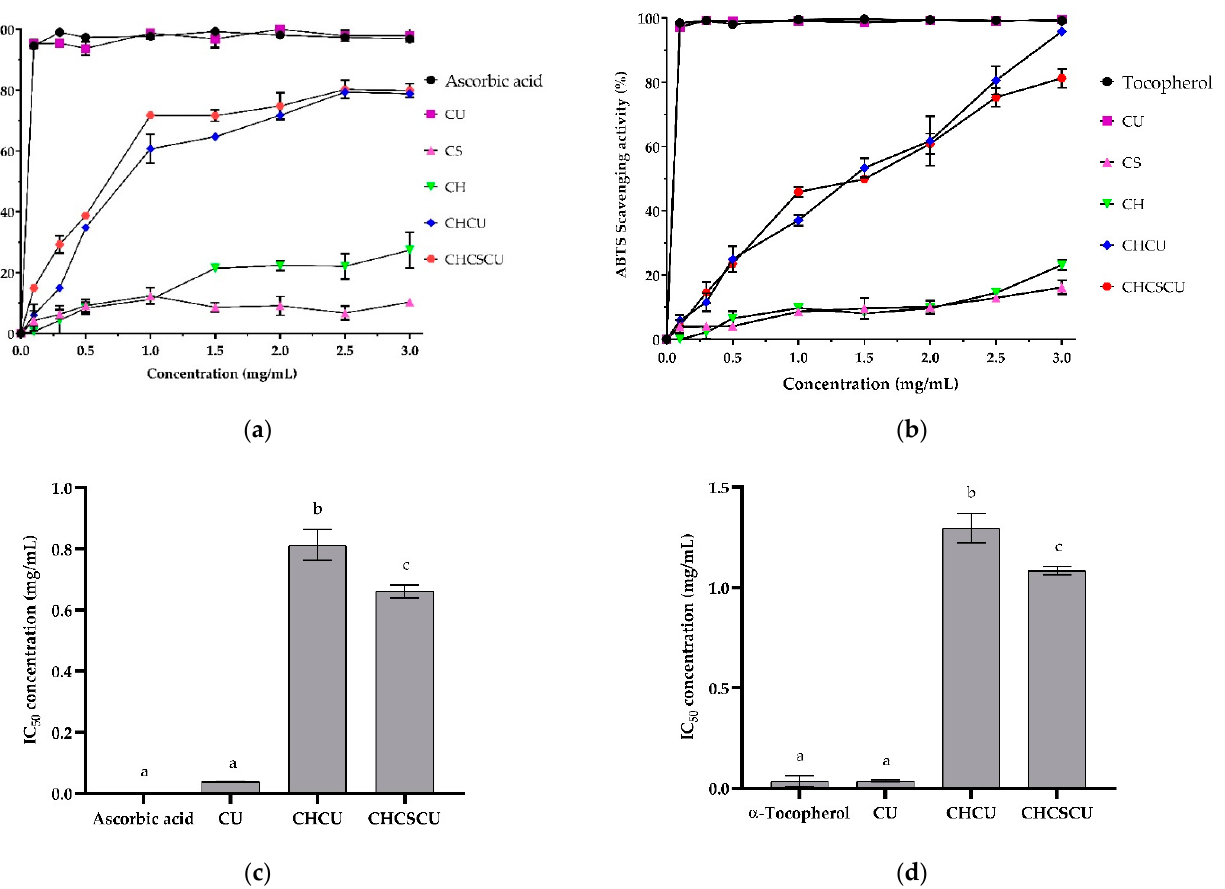
Figure 8. Antioxidant activities of curcumin (CU), chondroitin sulfate (CS) from head cartilage of skipjack tuna ( Katsuwonus pelamis ), chitooligosaccharides (CH), CU ‐ loaded nanoparticles (CHCU, and CHCSCU): ( a ) 2,2 ‐ diphenyl ‐ 1 ‐ picrylhydrazyl (DPPH) radical scavenging activities, with ascorbic acid used as the positive control; ( b ) 2,2 ′‐ azino ‐ bis (3 ‐ ethylbenzothiazoline) ‐ 6 ‐ sulfonic acid) (ABTS) radical scavenging activities, with α‐ Tocopherol used as the positive control; ( c ) the half maximal inhibitory concentration (IC 50 ) (DPPH); ( d ) IC 50 (ABTS). Values are expressed as means ± standard deviation (n = 3).